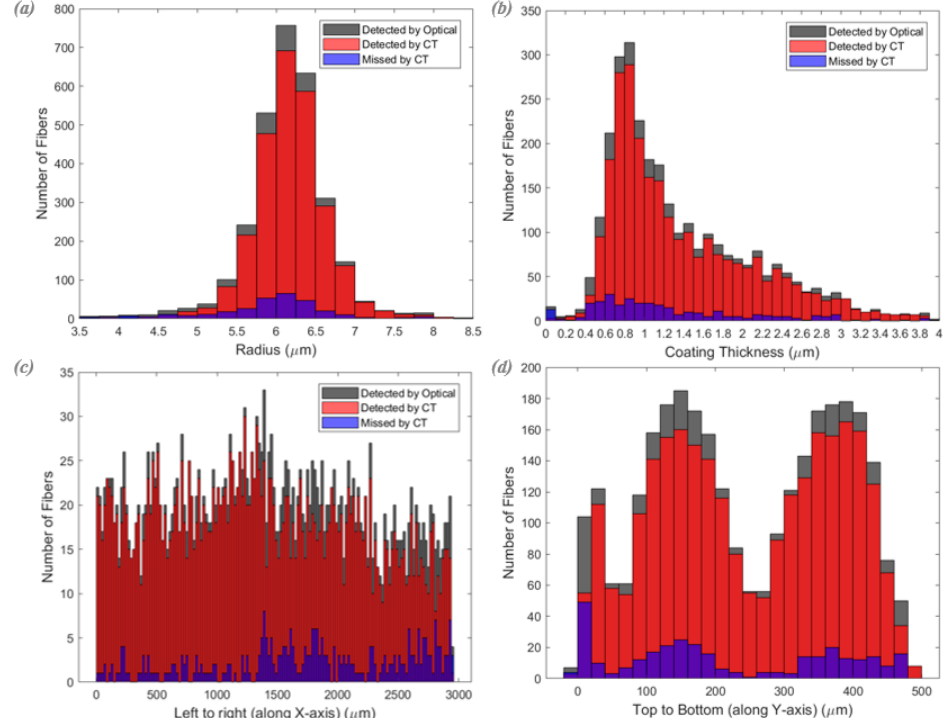
Figure 7. Fiber detection rates as a function of ( a ) fiber radius, ( b ) coating thickness, ( c ) location in horizontal direction in the image of Figure 1 (x-coordinate), and ( d ) location in vertical direction in the image of Figure 1 (y-coordinate). The combined detection rate is 93.7%. In ( a ) missed fibers are not correlated with variations in fiber radii. In ( b ) fibers with thin coatings are more likely to be missed. In ( d ) most of the missed fibers are located in the centers of the plies.